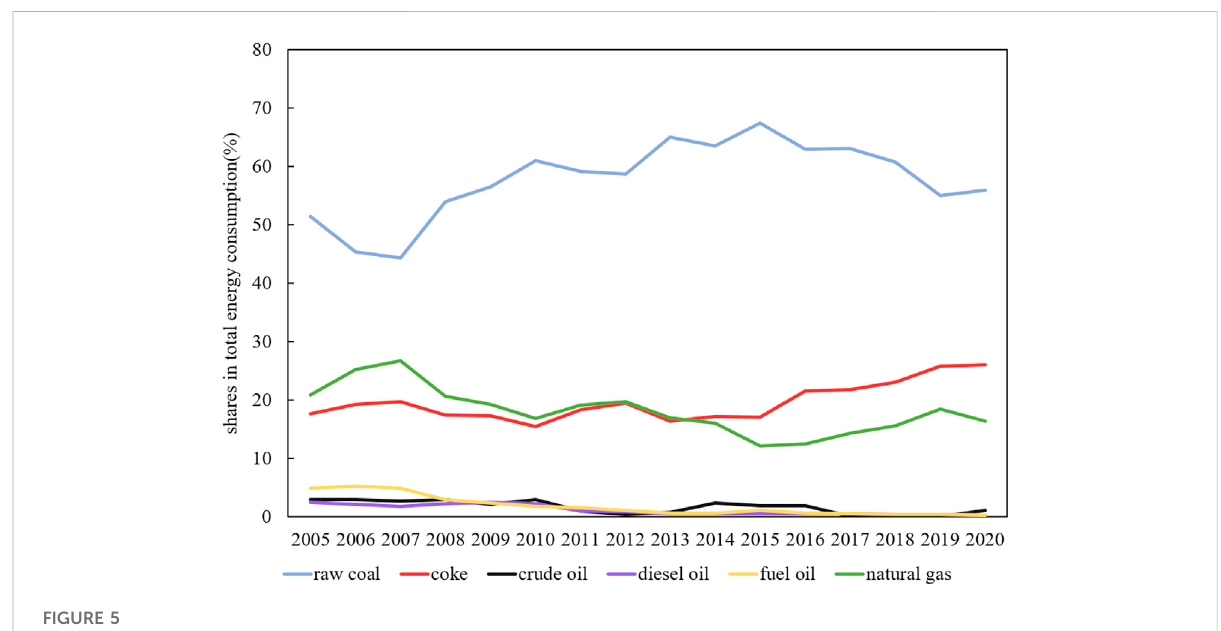
FIGURE 5 Energy consumption structure of chemical industry (Data source: China Energy Statistics